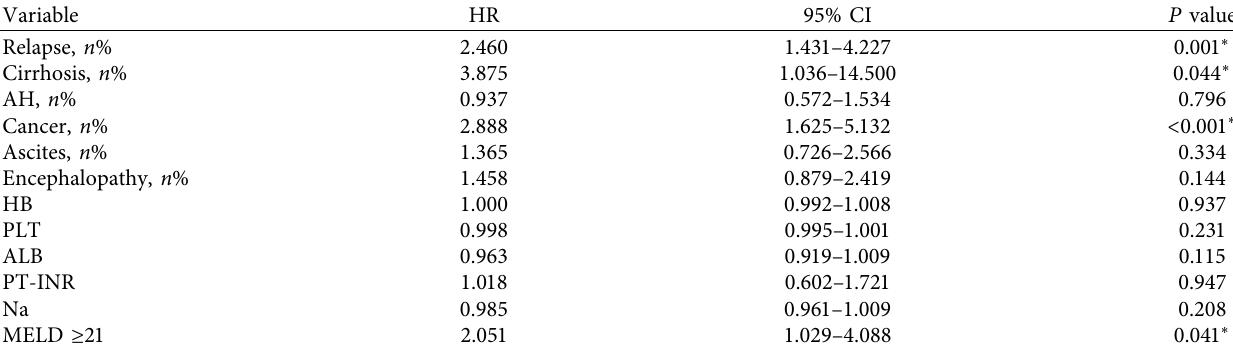
Table 3: Multivariable analysis of ALD patients in the training cohort.